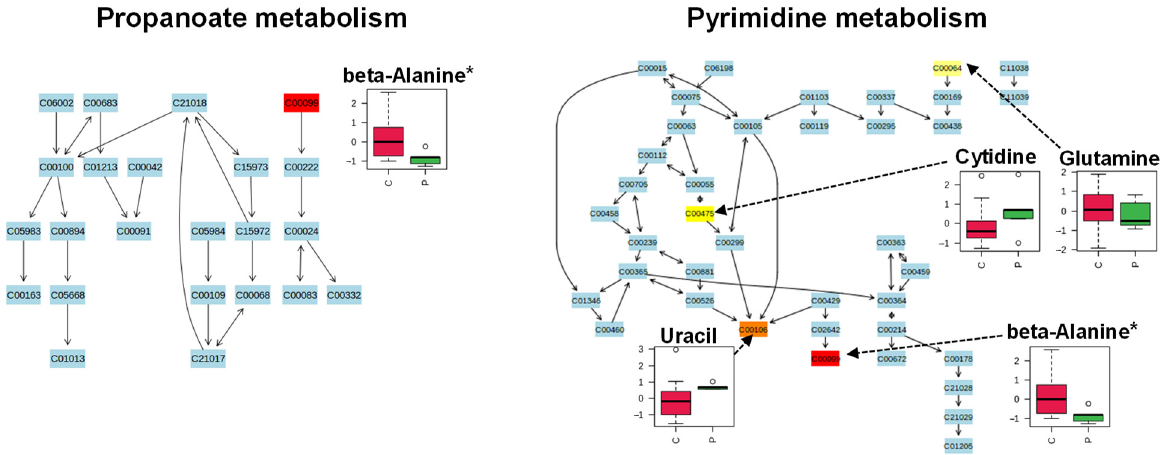
Figure A4. Detailed results of the pathway analysis in Figure 4d. Nodes with mapped data are colored. In each box plot, C and P indicate the data without and with depressive episodes, respectively. * p < 0.05.